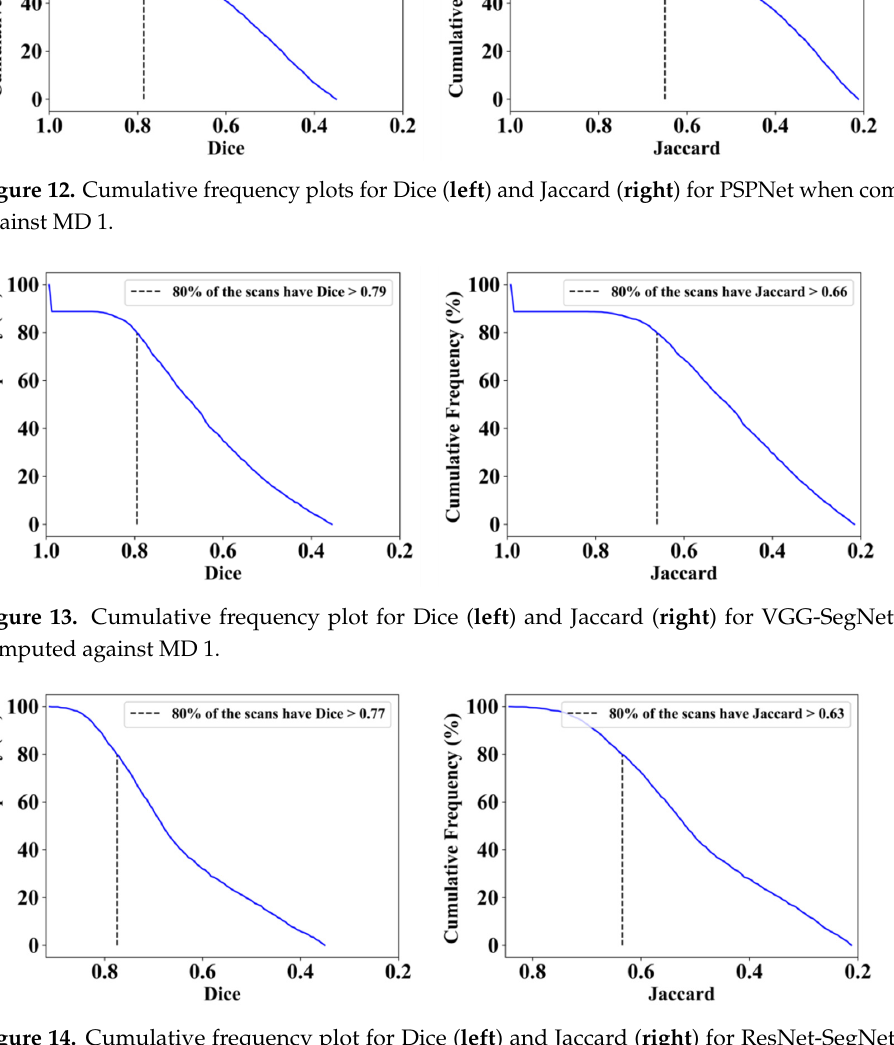
Figure 14. Cumulative frequency plot for Dice (left) and Jaccard (right) for ResNet ‐ SegNet when computed against MD 1.